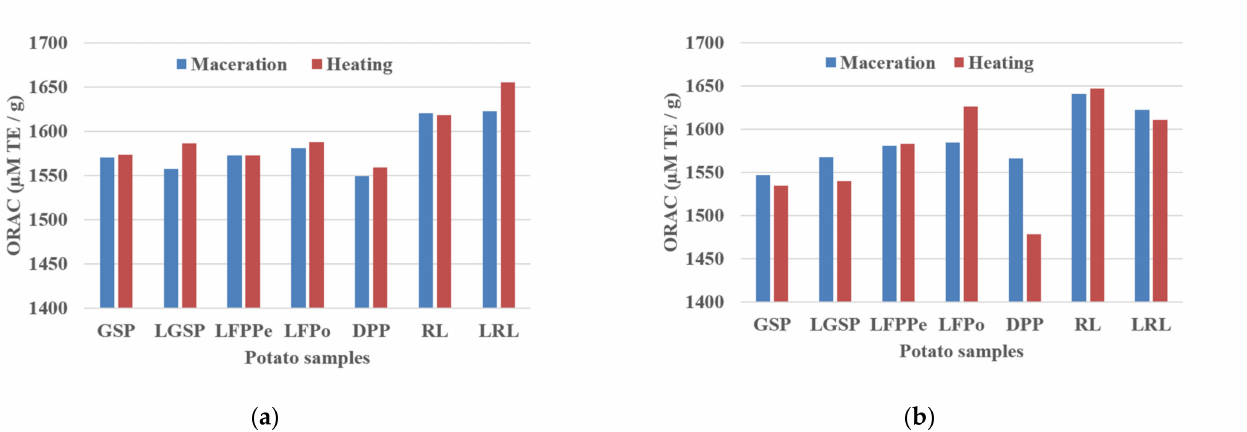
Figure 4. Variation of total oxygen radical absorbance capacity (ORAC) of potato samples under conditions of ( a ) MeOH: H 2 O; 4:1 and ( b ) EtOH: H 2 O; 4:1